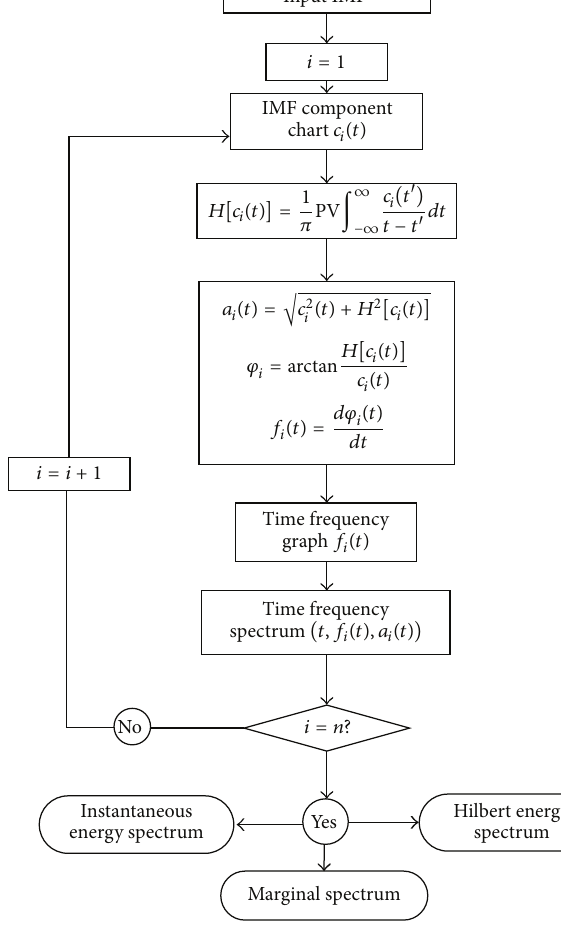
Figure 5: Calculation procedure diagram of Hilbert transform.